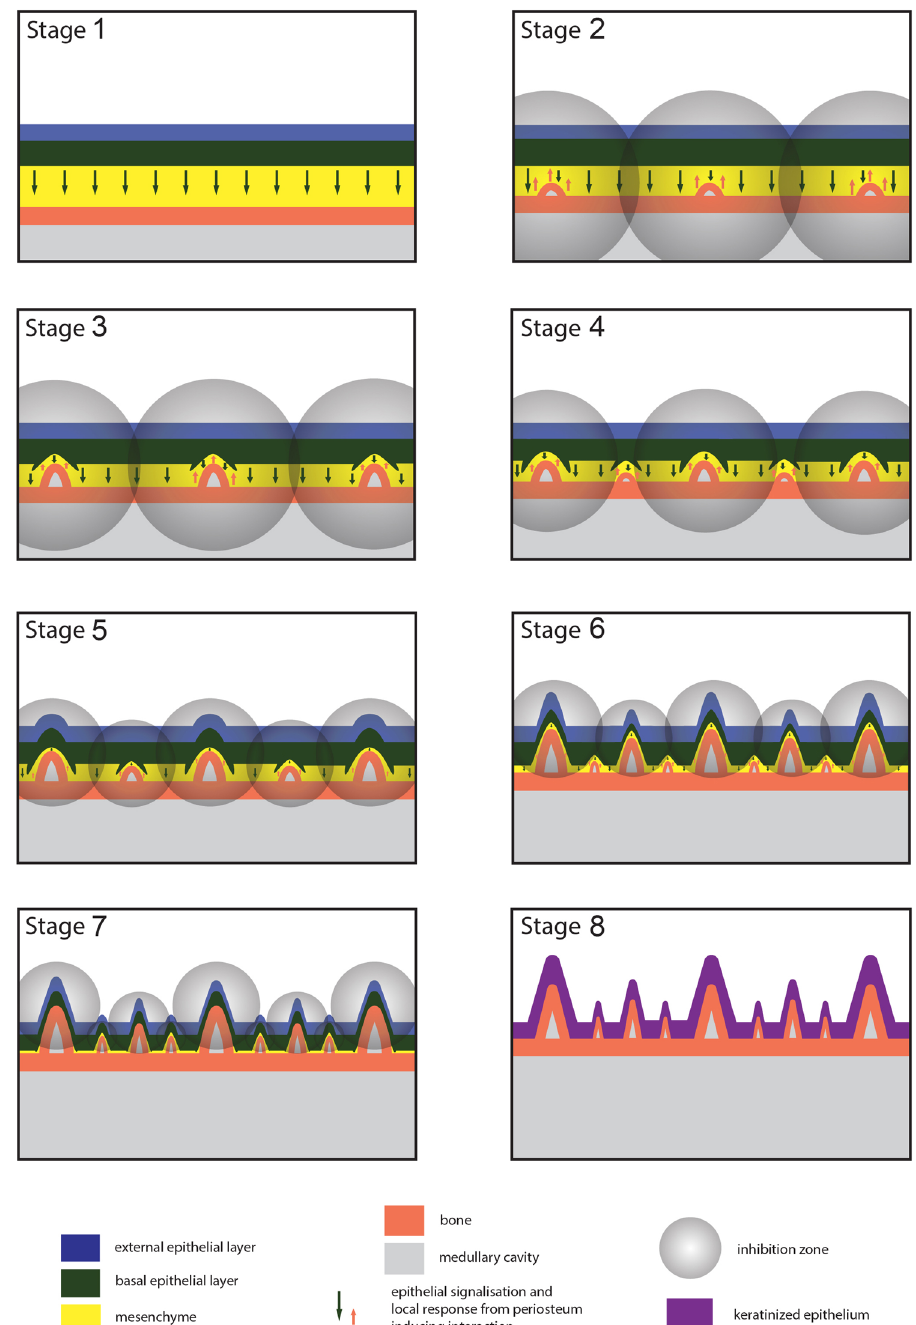
Figure 4. Proposed model of pseudodentition development. The differential growth of the differently ranked pseudoteeth is shown in eight stages, in the parasagittal section of a jaw for all pseudoteeth. For convenience of visibility, tissue thicknesses are exaggerated, ~10 × (bone, epithelium) and ~100 × (mesenchyme). Epithelial- mesenchymal interactions between the basal epithelium cells and the periosteal osteoblasts start when the intervening space becomes lower than ~100 µ m (Stage 2). This interaction ends when epithelial cells become keratinized (Stage